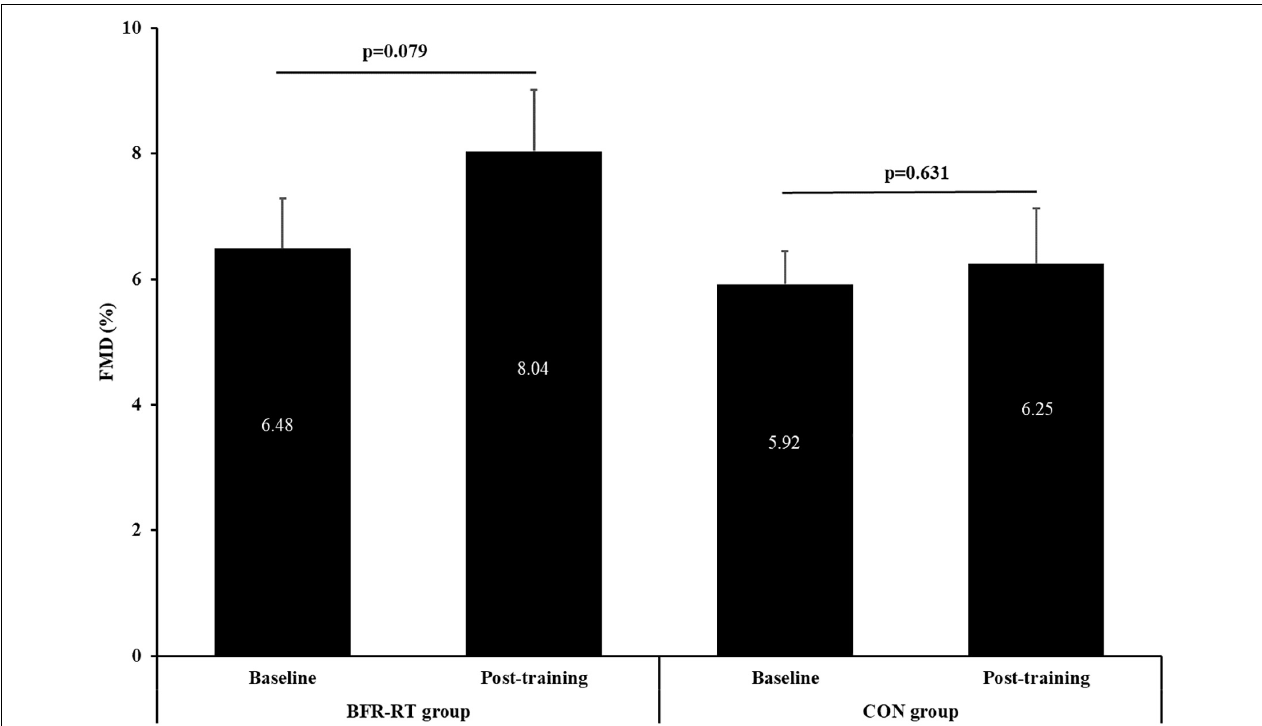
FIGURE 3 | Baseline and post-training values of flow-mediated vasodilation (FMD). BFR-RT group, blood flow restriction-resistance training group; CON group, control group. Values are presented as mean ±